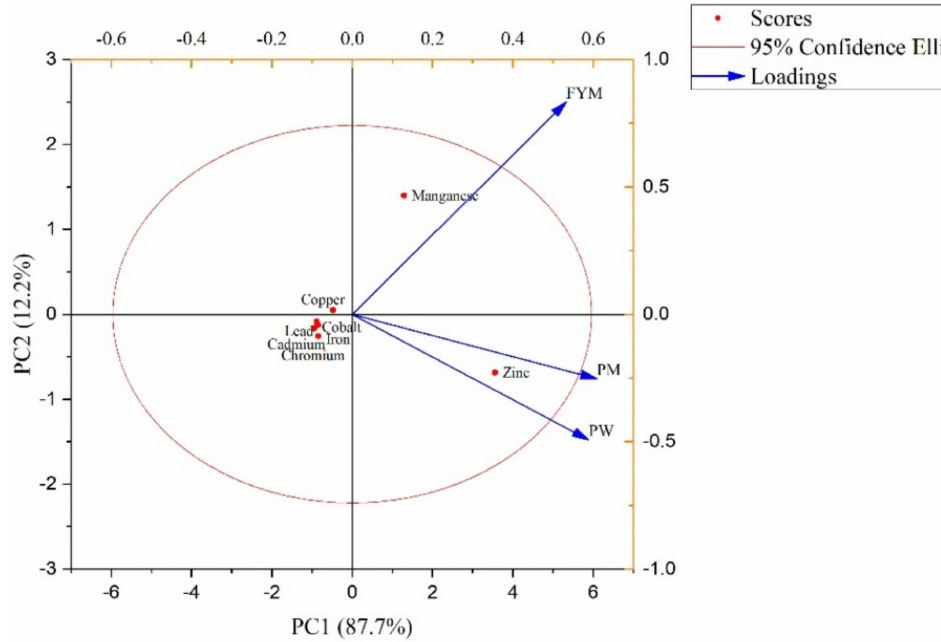
Figure 3. Principal component analysis of mean values of metal accumulated in garlic plants. It is a combination of score plot of metal ions (represented as dots) and loading plot of treatments (represented as vectors). FYM: farmyard manure, PW: poultry waste, PM: Press mud.